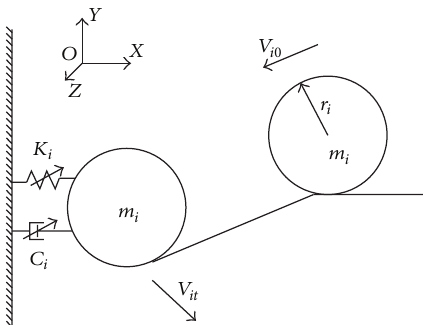
Figure 3: Model of collision between damper and